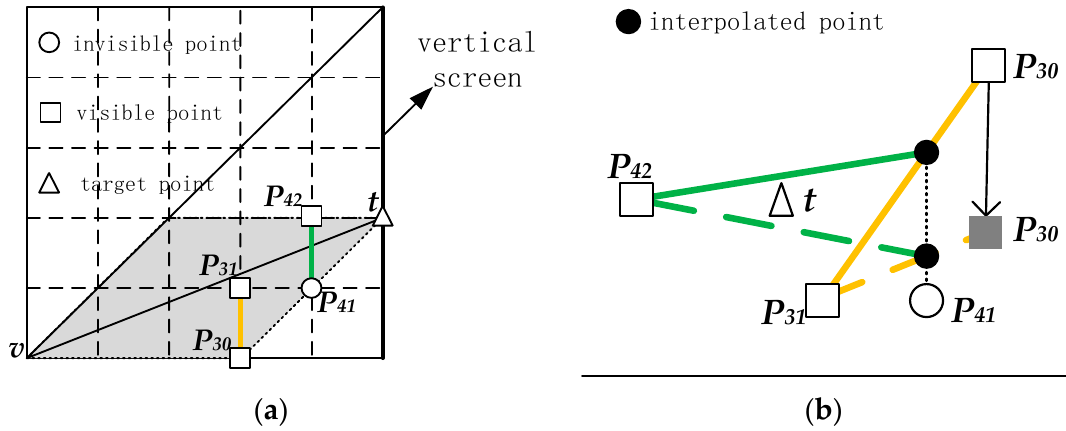
Figure 3. Only partial visible points in the dependency parallelogram influence the visibility computation of the target point. ( a ) demonstrates the relative positions of viewpoint v and target point t on a 2D grid. Suppose a vertical screen stands on the right edge of the grid and is perpendicular to the grid, ( b ) illustrates the result of the perspective projection of ( a ) originated at viewpoint onto the screen. ( a ) and ( b ) together show how the points in the dependency parallelogram contribute to the visibility of the target.